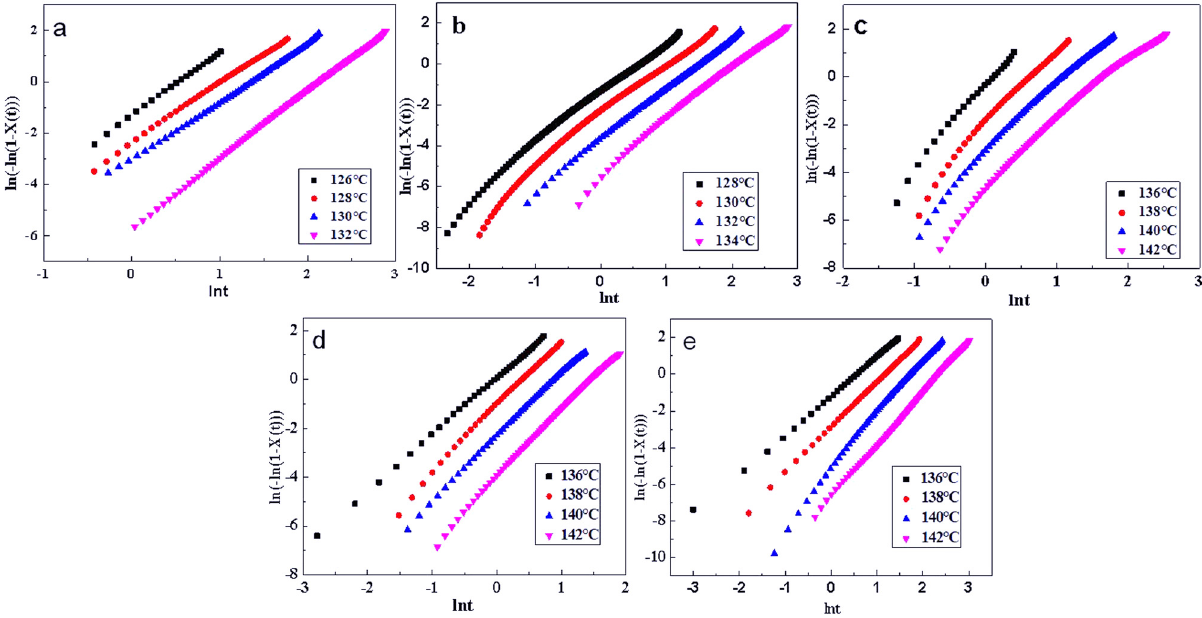
Figure 7: Fitting curves of ln [ − ln ( 1 − X ( t ))] as a function of ln t during the isothermal crystallization for ( a ) iPP, ( b ) iPP/S0, ( c ) iPP/S1, ( d ) iPP/S2, and ( e )